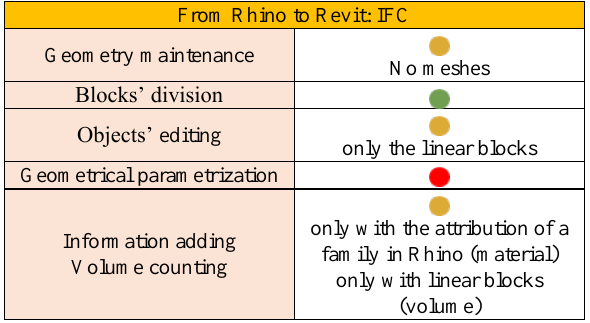
Table 6. Summarizing the result of the IFC test.